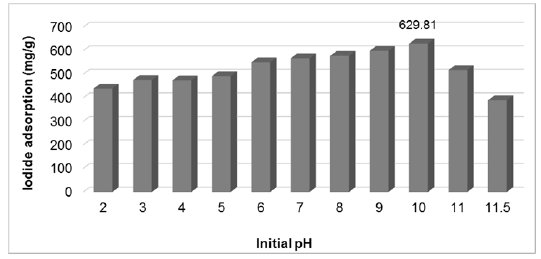
Fig. 6. Effect of pH for the adsorption of iodine on to the adsorbent